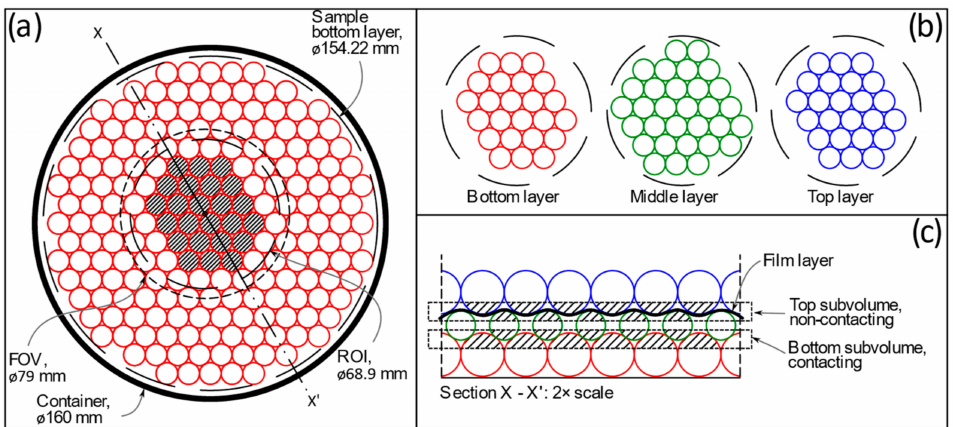
Figure 2. Pellet sample schematic: ( a ) plane view of bottom layer with pellets used in the analysis indicated by hatched region; ( b ) plane view of bottom, middle and top layers of pellets within the central ROI used in the analysis; ( c ) X-X’ vertical cross section through central ROI showing the top and bottom subvolumes, the film layer separating the middle and top lattices, and pellets used in the analysis indicated by hatched